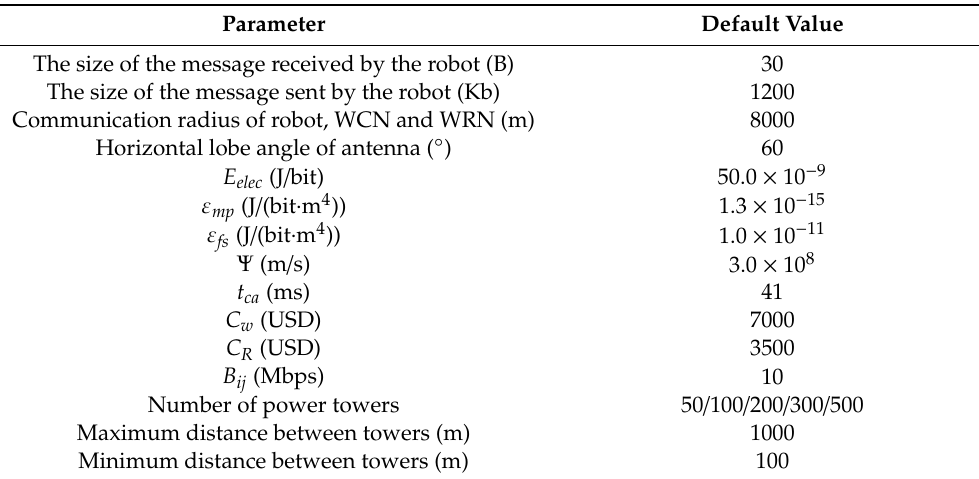
Table 2. Default parameters for simulations.